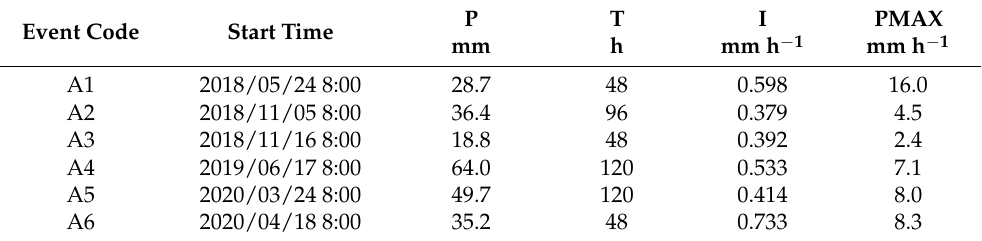
Table 3. Characteristics of precipitation events recorded at field sites in BTQ.